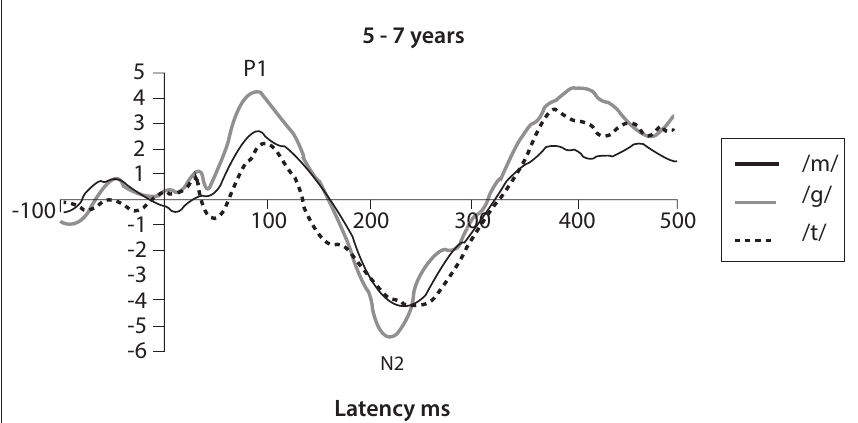
Fig. 2. Grand averaged CAEP waveforms in response to the three speech stimuli in the 5 - 7-year age